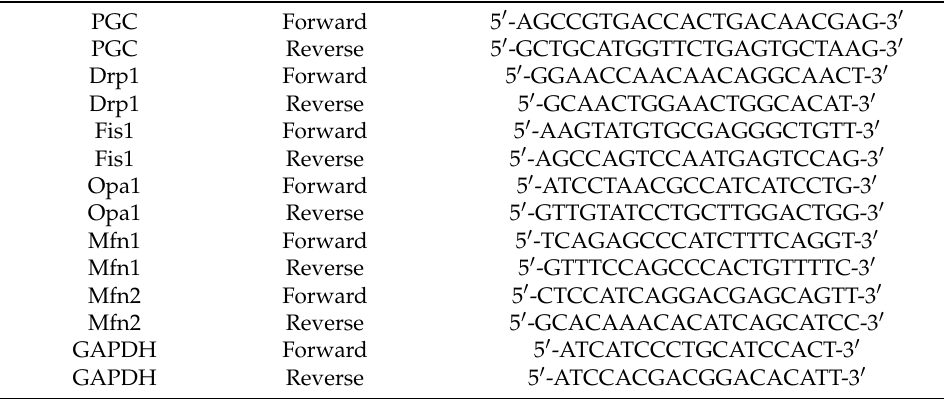
Table 1. Primers for real-time PCR